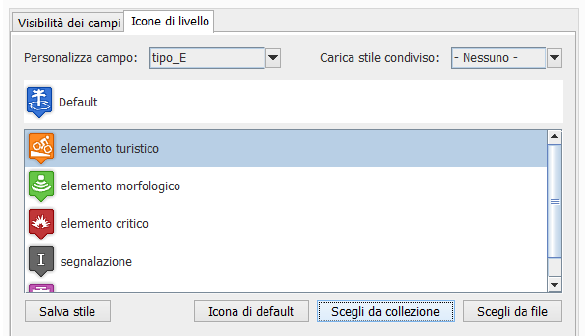
Figure 8. Marker icons thematization by attributes